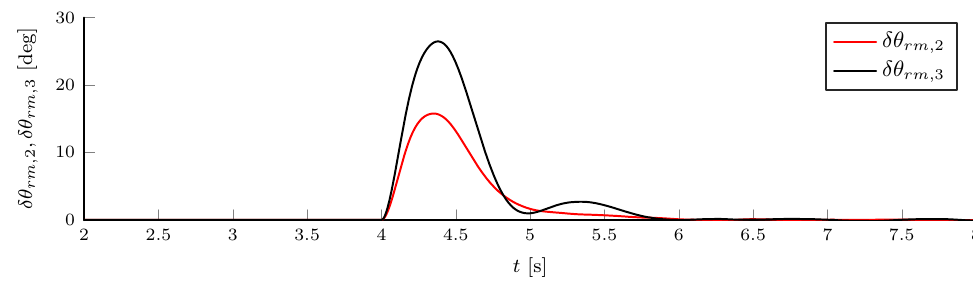
Figure 24. Individual angle differences; current-source control. Individual rotor angle differences for the secondary motors, referenced from the pri- mary motor, are shown in Figure 24. Just after t = 4 s, synchronization errors are initially observed before being resolved by the proposed control scheme after approximately 1.5 s.